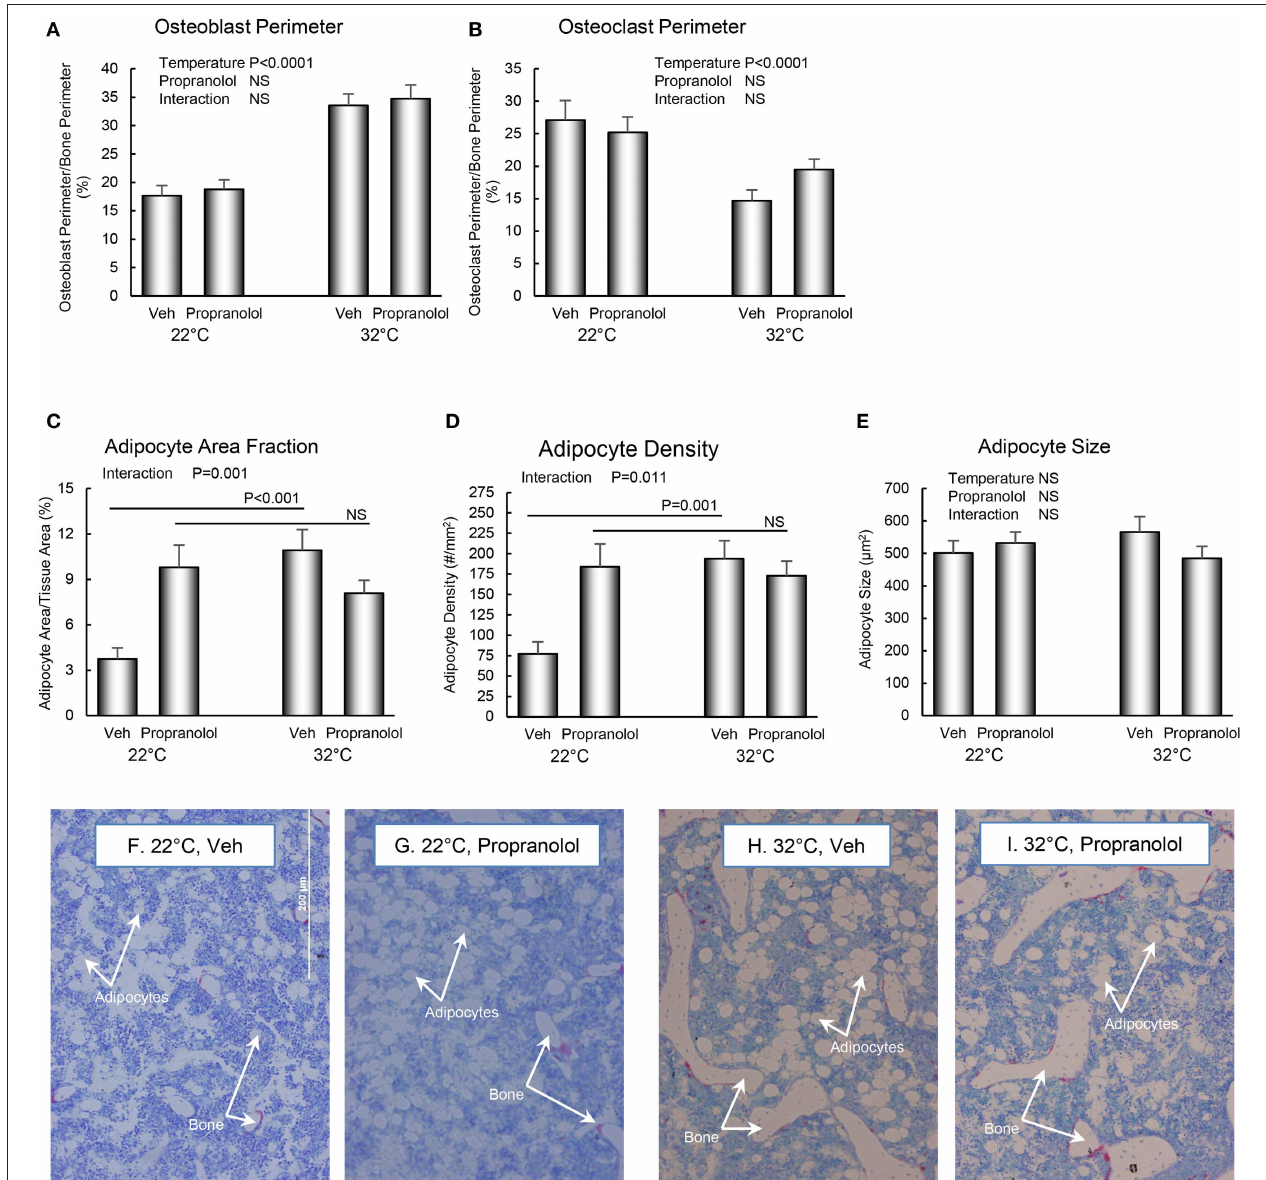
FIGURE 4 | Effect of housing temperature (temperature) and treatment with propranolol (treatment) on indices of bone formation, bone resorption, and marrow adiposity in distal femur metaphysis: (A) osteoblast perimeter, (B) osteoclast perimeter, (C) adipocyte area fraction, (D) adipocyte density, and (E) adipocyte size. Representative images of the bone marrow compartment showing bMAT and cancellous bone in each treatment group in the distal femur metaphysis are shown in (F–I) . Data are mean ± SE. N = 10/group. Post-hoc analysis was performed when there was a significant interaction term.